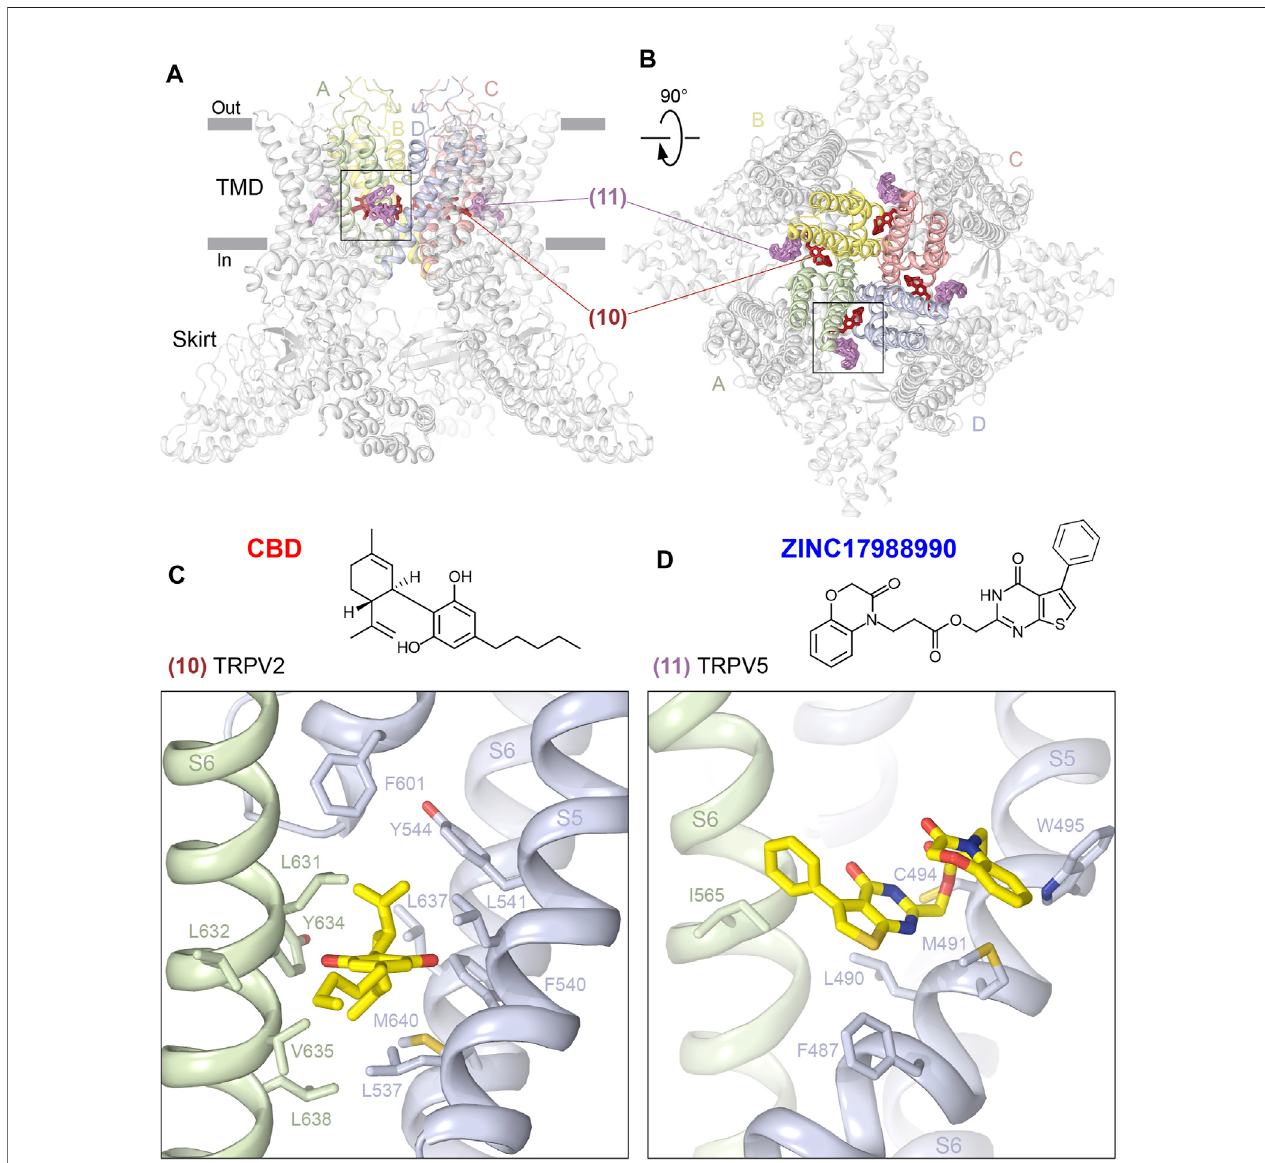
FIGURE5| Portalsites. (A – B) ,Side (A) andtop (B) viewsoftheTRPV1 tetramer(gray;PDBID:7LQY)withthedeep (10)and shallow(11)portalsites illustrated by ligands in brown and pink, respectively. Rectangles indicate the region expanded in close-up views. (C – D) , Close-up views of the deep portal site in TRPV2 with